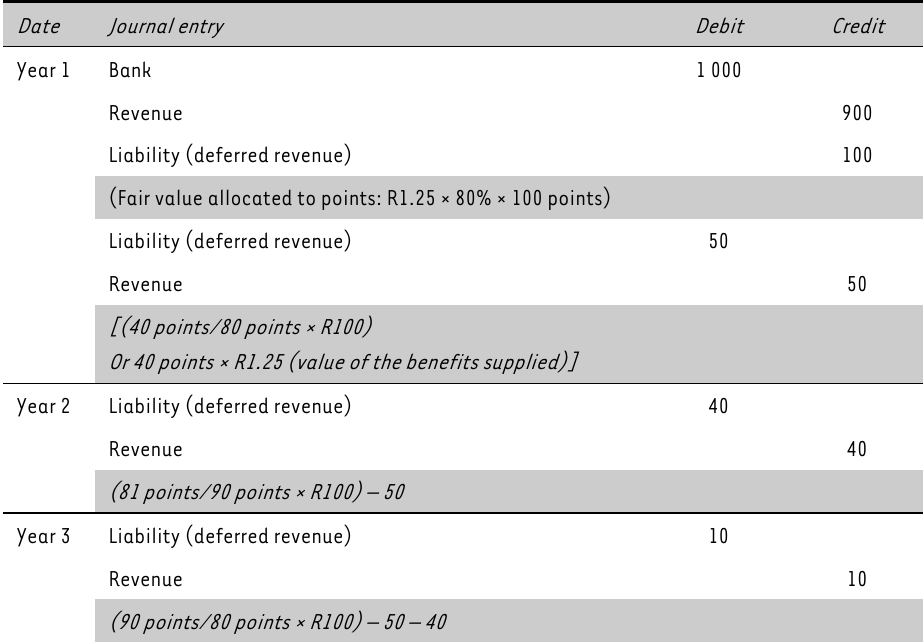
General journal entries of the grocery